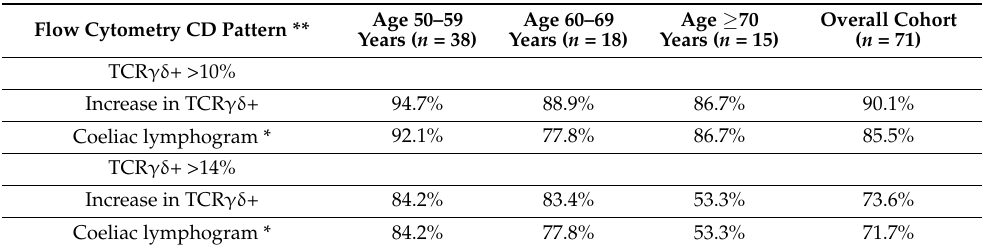
Table 2. CD diagnosis sensitivity of the two coeliac cytometric patterns in patients with villous atrophy in function of the age